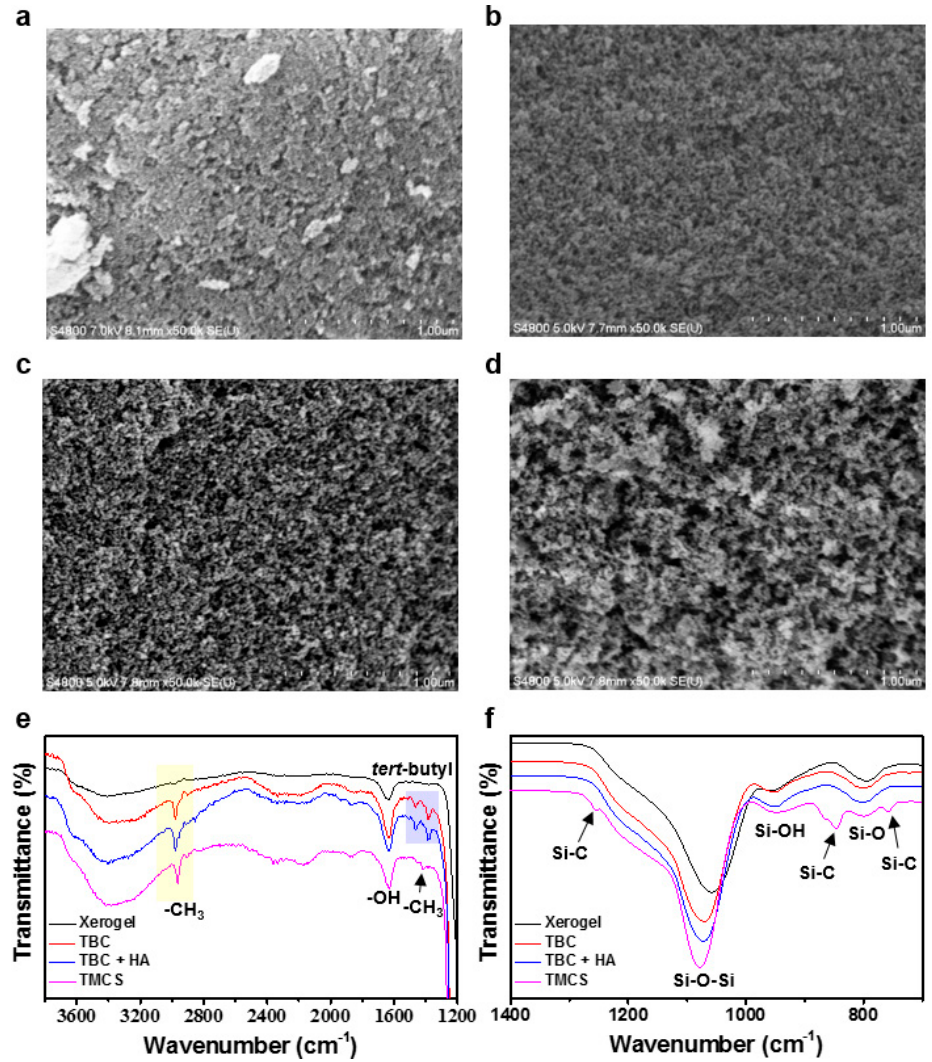
Figure 1. Schematic of ( a ) the synthesis process of catechol-modified water-glass-based silica aerogel, and ( b ) the proposed surface structure of 4- tert -butylcatechol (TBC) + hexylamine (HA) case (left) and polydopamine (PDA) + TBC + HA case (right).